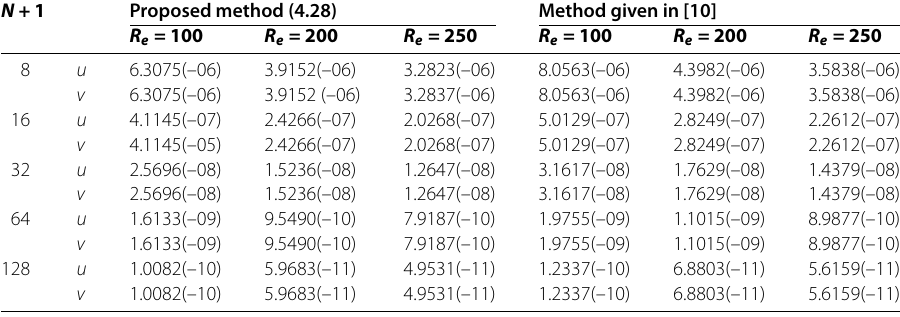
Table 16 Example 8: Maximum absolute errors at t = 1, α 1 = β 1 = 2, α 2 = β 2 = –1, λ = 3.2 N +